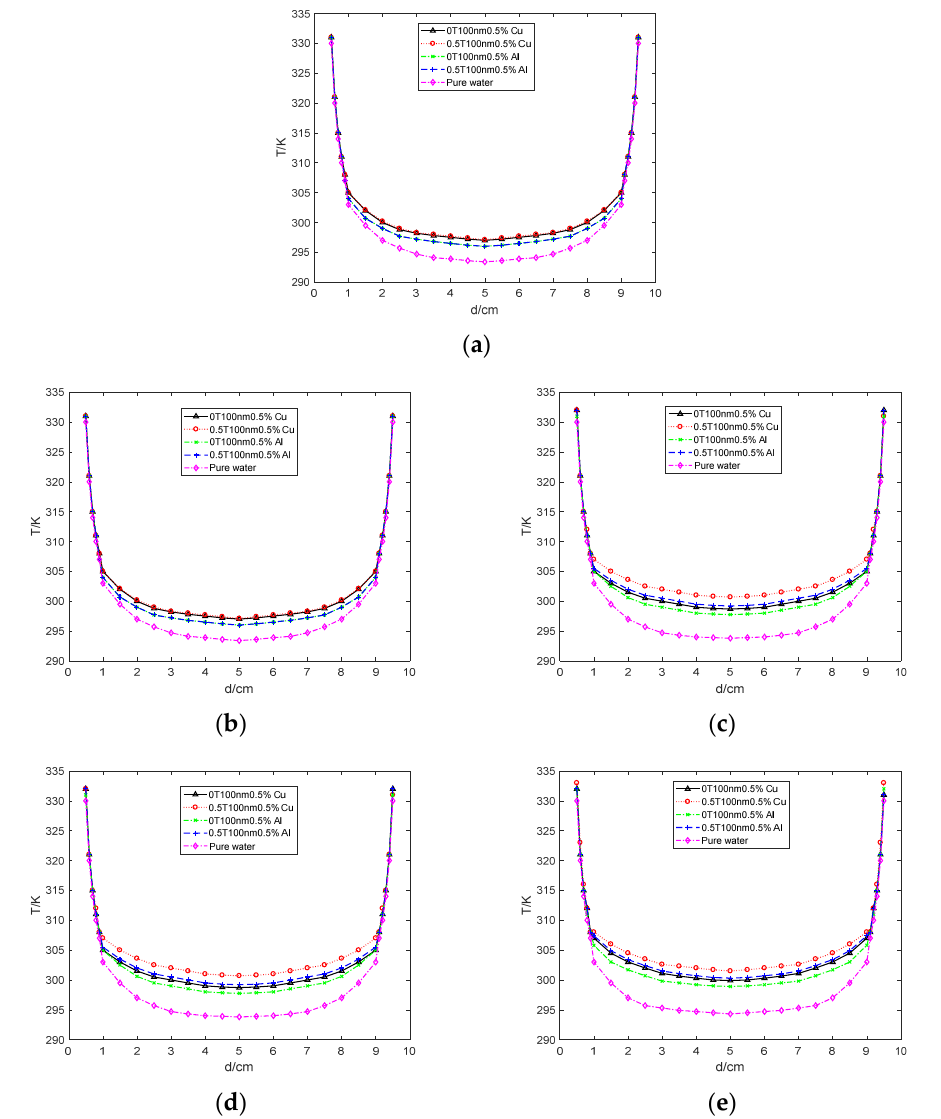
Figure 5. The temperature distributions of Cu-H 2 O and Al-H 2 O nanofluids flow along the diameter on faces 2 ( a ), 3 ( b ), 4 ( c ), 5 ( d ), and 6 ( e ), respectively. The magnetic fields were applied along the Z direction.